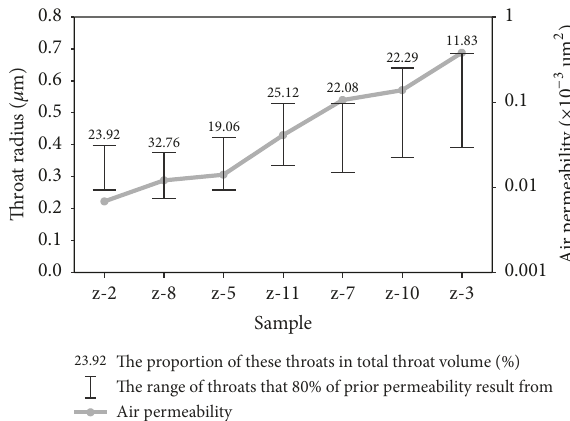
Figure 9: The relationship between throat radius and air permeability of the samples from Upper Triassic Chang 7 Member, Odors Basin. The prior permeability (80%) results from a small portion of large throats, and the trend of air permeability has a close relationship with the radii of the large